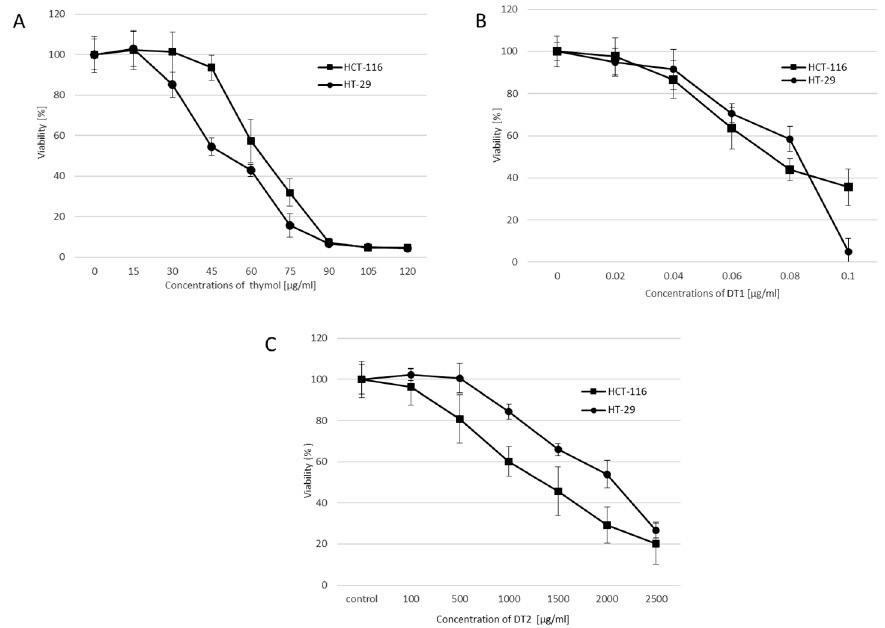
Figure 2. Cytotoxic effect of thymol-standard ( A ), DT1 ( B ), and DT2 ( C ) on tumor cell lines HT-29 and HCT-119 after 24 h of treatment. Data are represented by means ± SD of three independent experiments.